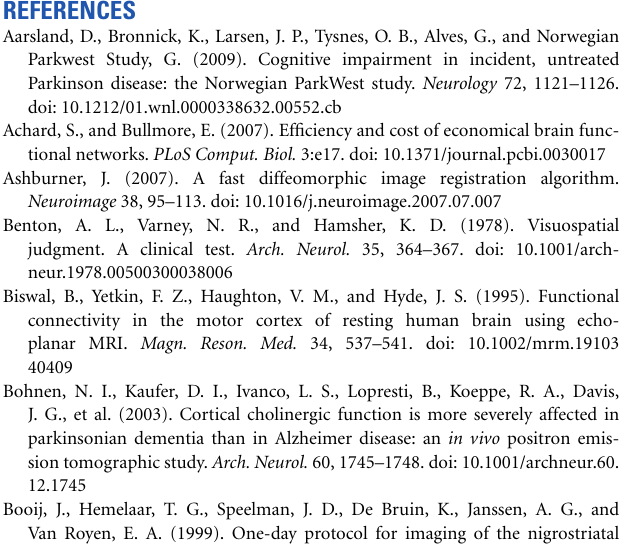
Figure S3 | Latent variable selection. The figure shows Root Mean Squared Error Prediction (RMSEP) as a function of a number of PLS latent variables (LVs). The maximum number of LVs was selected that minimized total training (red dashed line) and leave-one-out cross-validation (green solid line) errors for all the domains ( n =